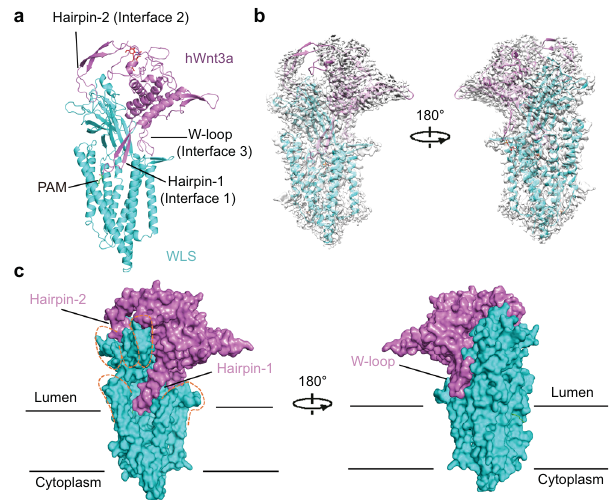
Fig. 1 Cryo-EM structure of human WLS in complex with Wnt3a. a Overall structure of WLS-Wnt3a complex. Structure is shown in cartoon with WLS colored in cyan and Wnt3a colored in violet. The sugar moiety on Wnt3a is shown as red sticks, and PAM modi fi ed on Wnt3a is shown as green sticks. Key structural elements of Wnt3a at interfaces are indicated. b Fit of WLS- Wnt3a complex model with the 2.2 Å cryo-EM map. Wnt3a is colored in violet and WLS is colored in cyan. The map is generated from the 2.2 Å map in Chimera 65 at contour level of 0.2 with dust hidden. c Complex structure is shown in surface. Model is colored in same pattern as in Fig. 1b. The contour of hand shape of WLS is shown in orange dash lines. All structural fi gures are generated with PyMOL 66